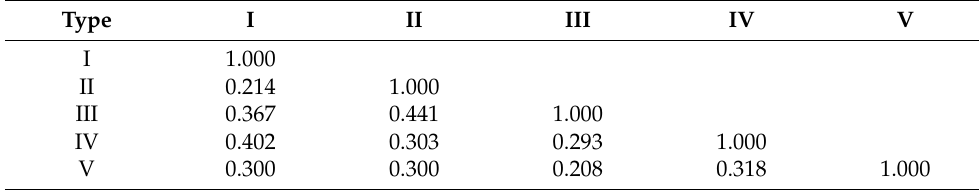
Table 5. Correlation coefficients between